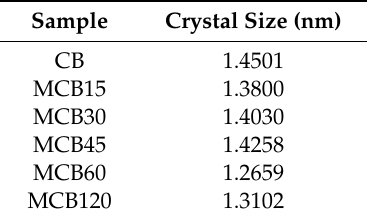
Table 3. The crystal size of carbon black (CB) modified with citric acid to di ff erent reaction